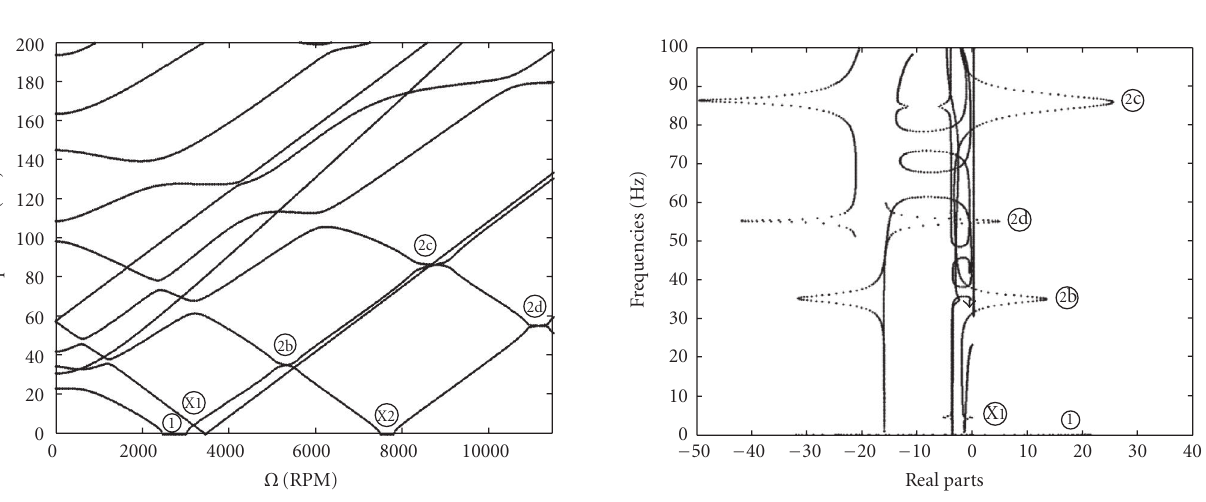
Figure 6: Zoom near extremity